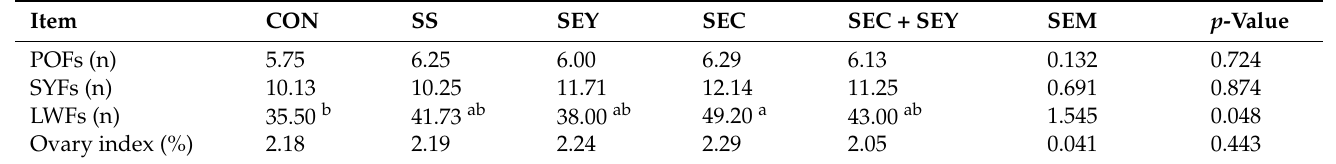
Table 5. Effects of different Se sources on reproductive organ development in laying hens 1 .